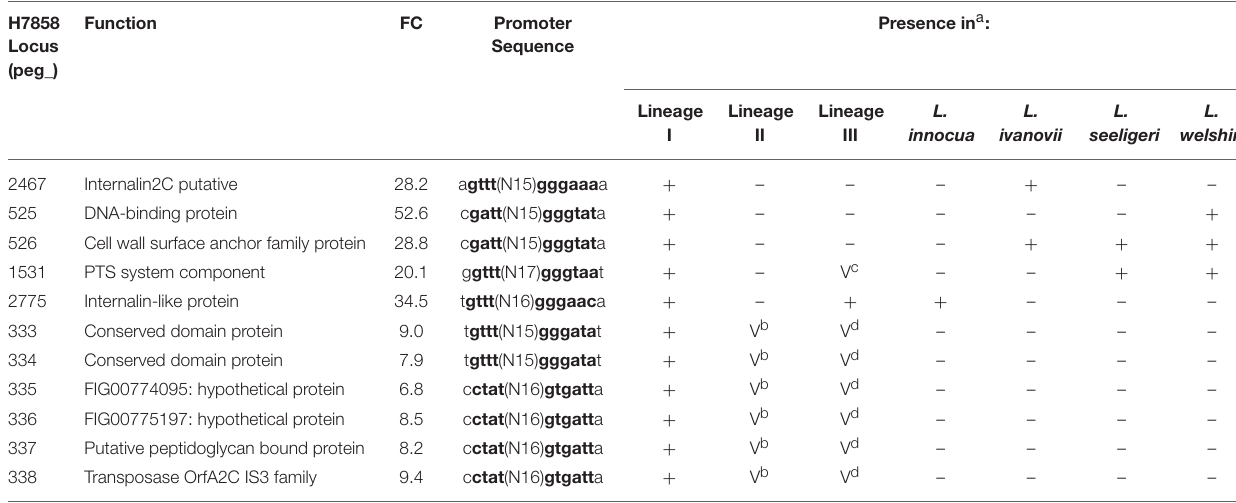
TABLE 7 | SigB-dependent genes in H7858 with no homolog in 10403S. H7858